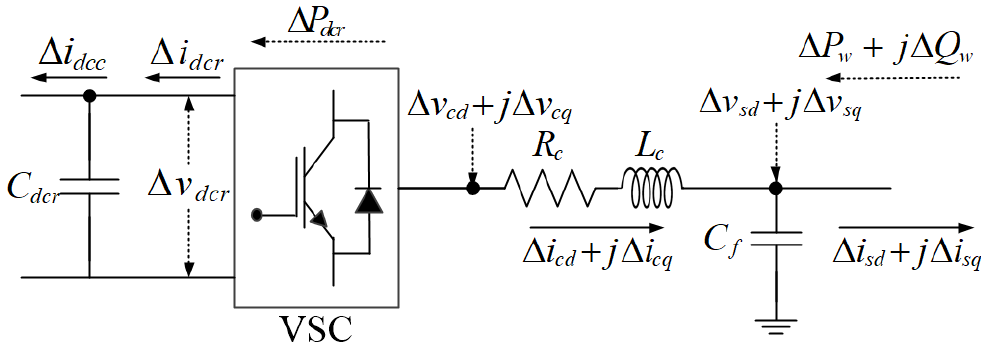
Figure 1. Configuration of the wind side ac